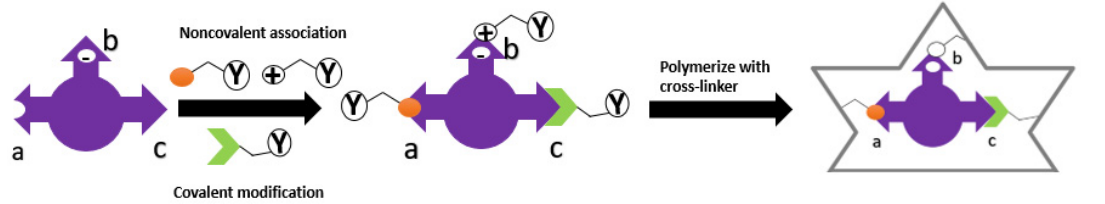
Figure 3. Type of interaction between template and monomer: ( a ) Noncovalent (nonionic) ( b ) noncovalent (electro- static/ionic) ( c ) covalent.